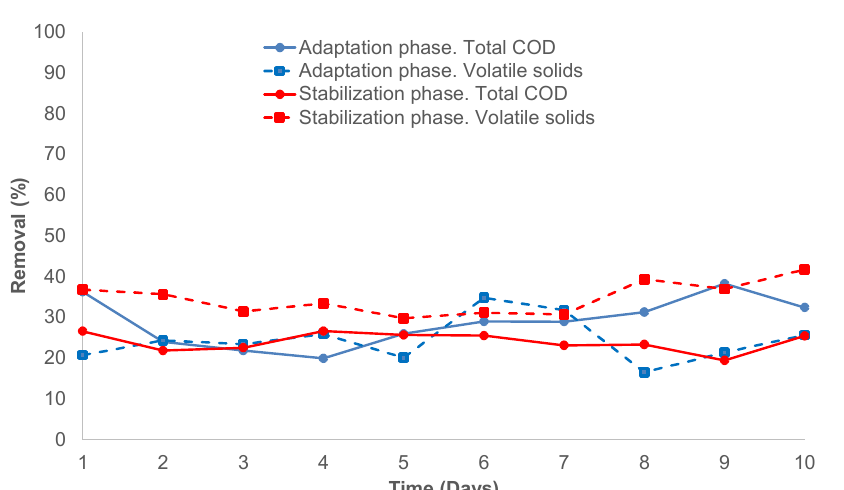
Figure 6. ISCW feeding in semi-continuous mode in both the adaptation and stabilization phases: percent of total COD and VS removed.